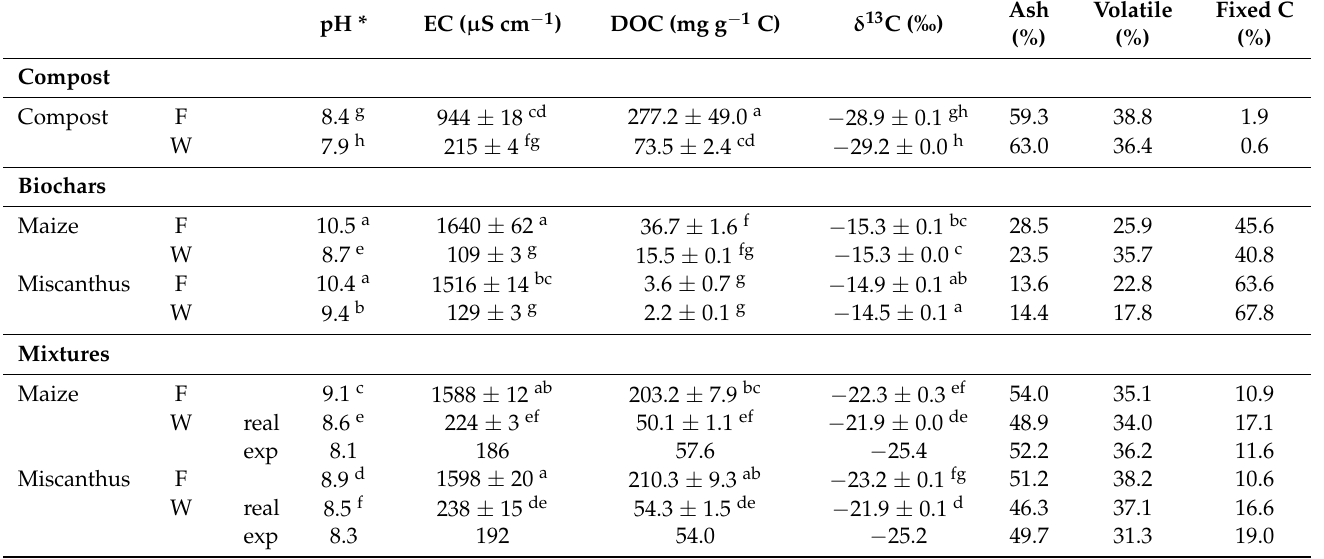
Table 3. Chemical characteristics of fresh (F) and weathered (W) compost, biochars and biochar-compost mixtures. Expected (exp.) values were calculated for the weathered mixtures. EC: electric conductivity; DOC: dissolved organic carbon. Data are presented as means ± sd ( n = 3) for pH, EC, DOC and δ 13 C. Proximate analysis was carried out for 1 sample. The letters represent differences among